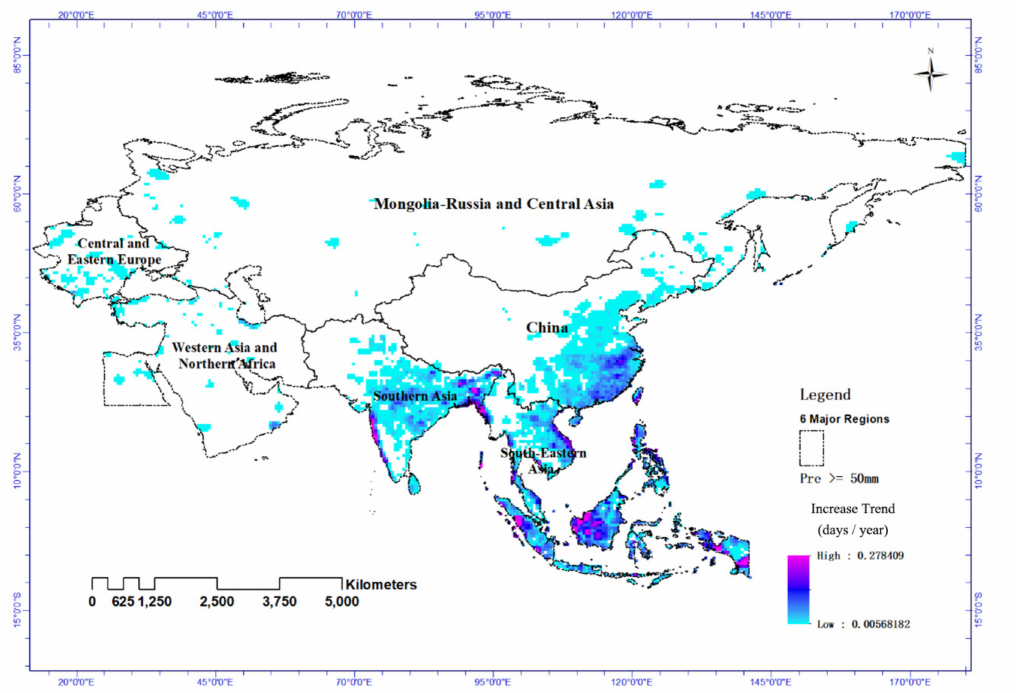
Figure 3. Inter-annual variation trend of precipitation during 24 h with at least 50 mm from 1985 to